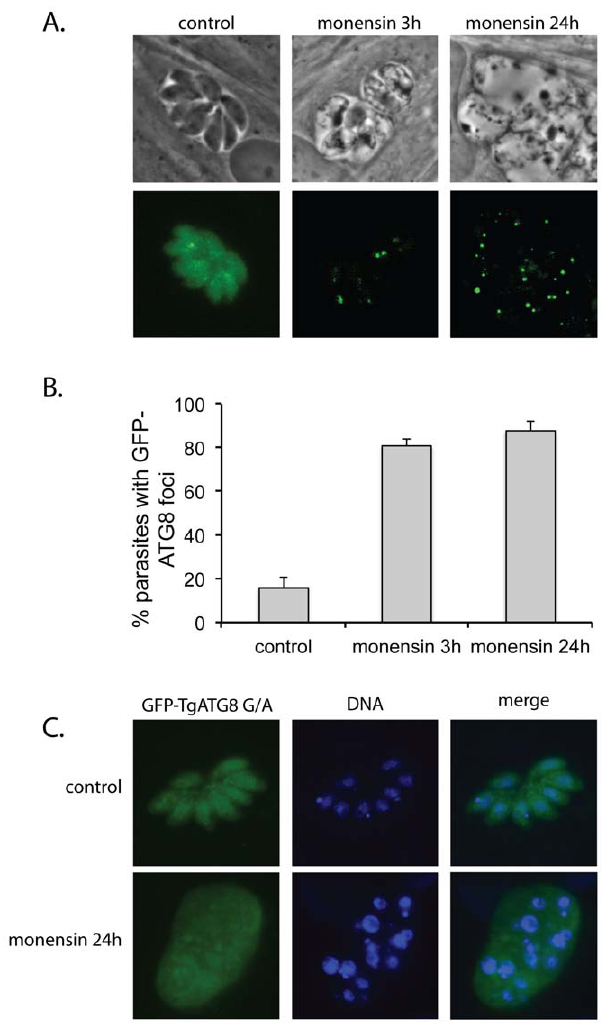
Figure 4. Monensin induces formation of GFP-ATG8 foci in intracellular parasites. (A) Phase contrast and deconvolved im- mmuofluorescent micrographs of T. gondii expressing GFP-tagged ATG8 after exposure to monensin (0.75 ng/ml) for 3 hours or 24 hours. (B) Percentage of parasites containing one or more GFP-ATG8 foci after exposure to monensin. Each bar represents the mean value for three independent replicates. Error bar=1 standard deviation. (C) Decon- volved immmuofluorescent micrographs show that T. gondii expressing a GFP-tagged ATG8 in which the terminal glycine was replaced with an alanine (GFP-TgATG8-G/A) do not show formation of GFP-ATG8 foci even after 24 hours exposure to monensin (0.75 ng/ml).